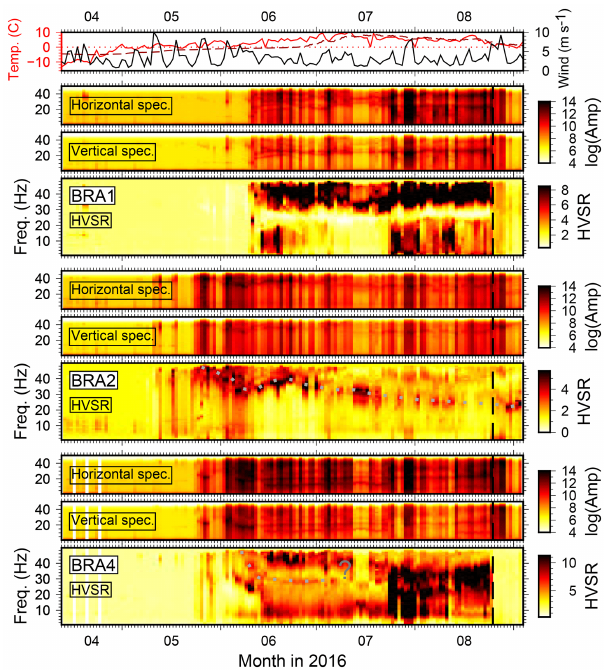
Figure 2. Vertical and horizontal component spectral amplitudes and HVSRs at three stations of the temporary deployment. Dot- ted lines indicate trend of gliding peak frequencies, question marks ambiguous or unclear peaks, and vertical dashed line date of in- strument maintenance (BRA array) or removal (KBSA array). Air temperature (red) and daily averaged wind speed (black) measured in Ny-Ålesund are shown on top. The dashed dark red line is soil temperature at 0.39m depth at the Bayelva permafrost observation site (Boike et al., 2018) at 1.6km distance from BRA and 2.4km from